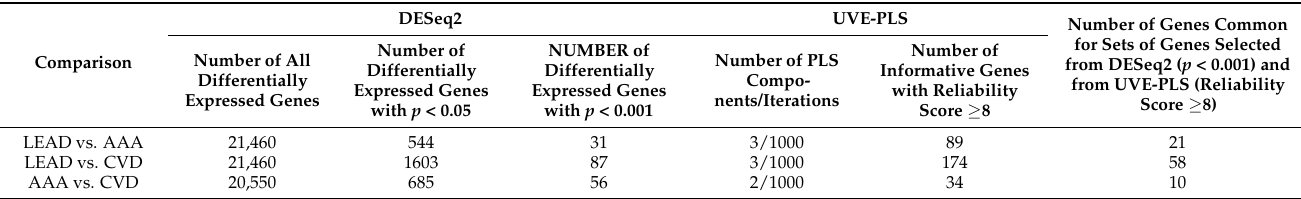
Table A2. General results of differential gene expression analysis performed using DESeq2 and UVE-PLS methods obtained for comparisons: LEAD vs. AAA, LEAD vs. CVD and AAA vs. CVD.